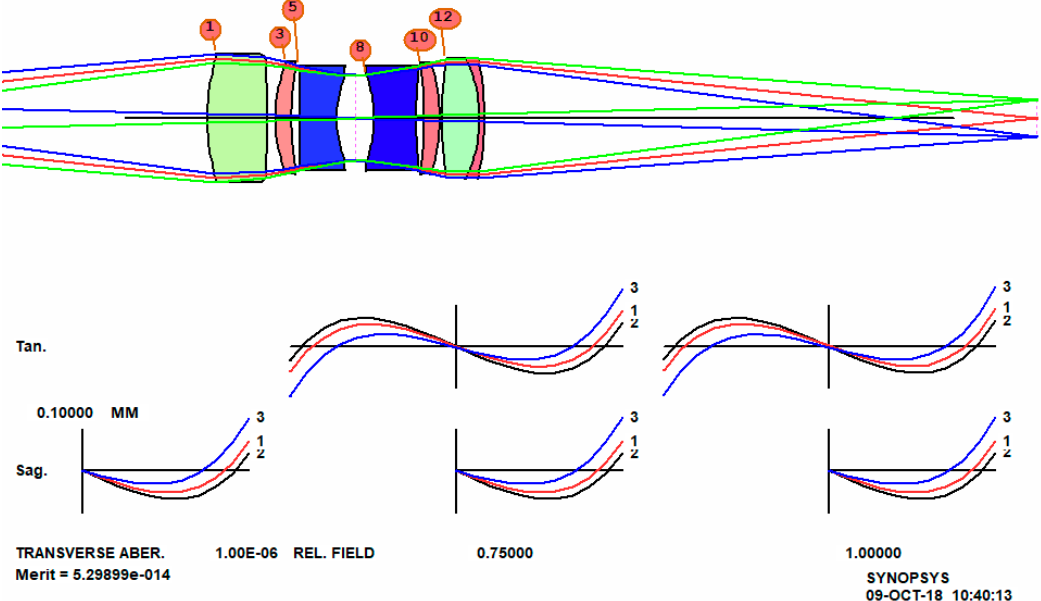
Figure 2. Unity-magnification double-Gauss objective, from the literature.